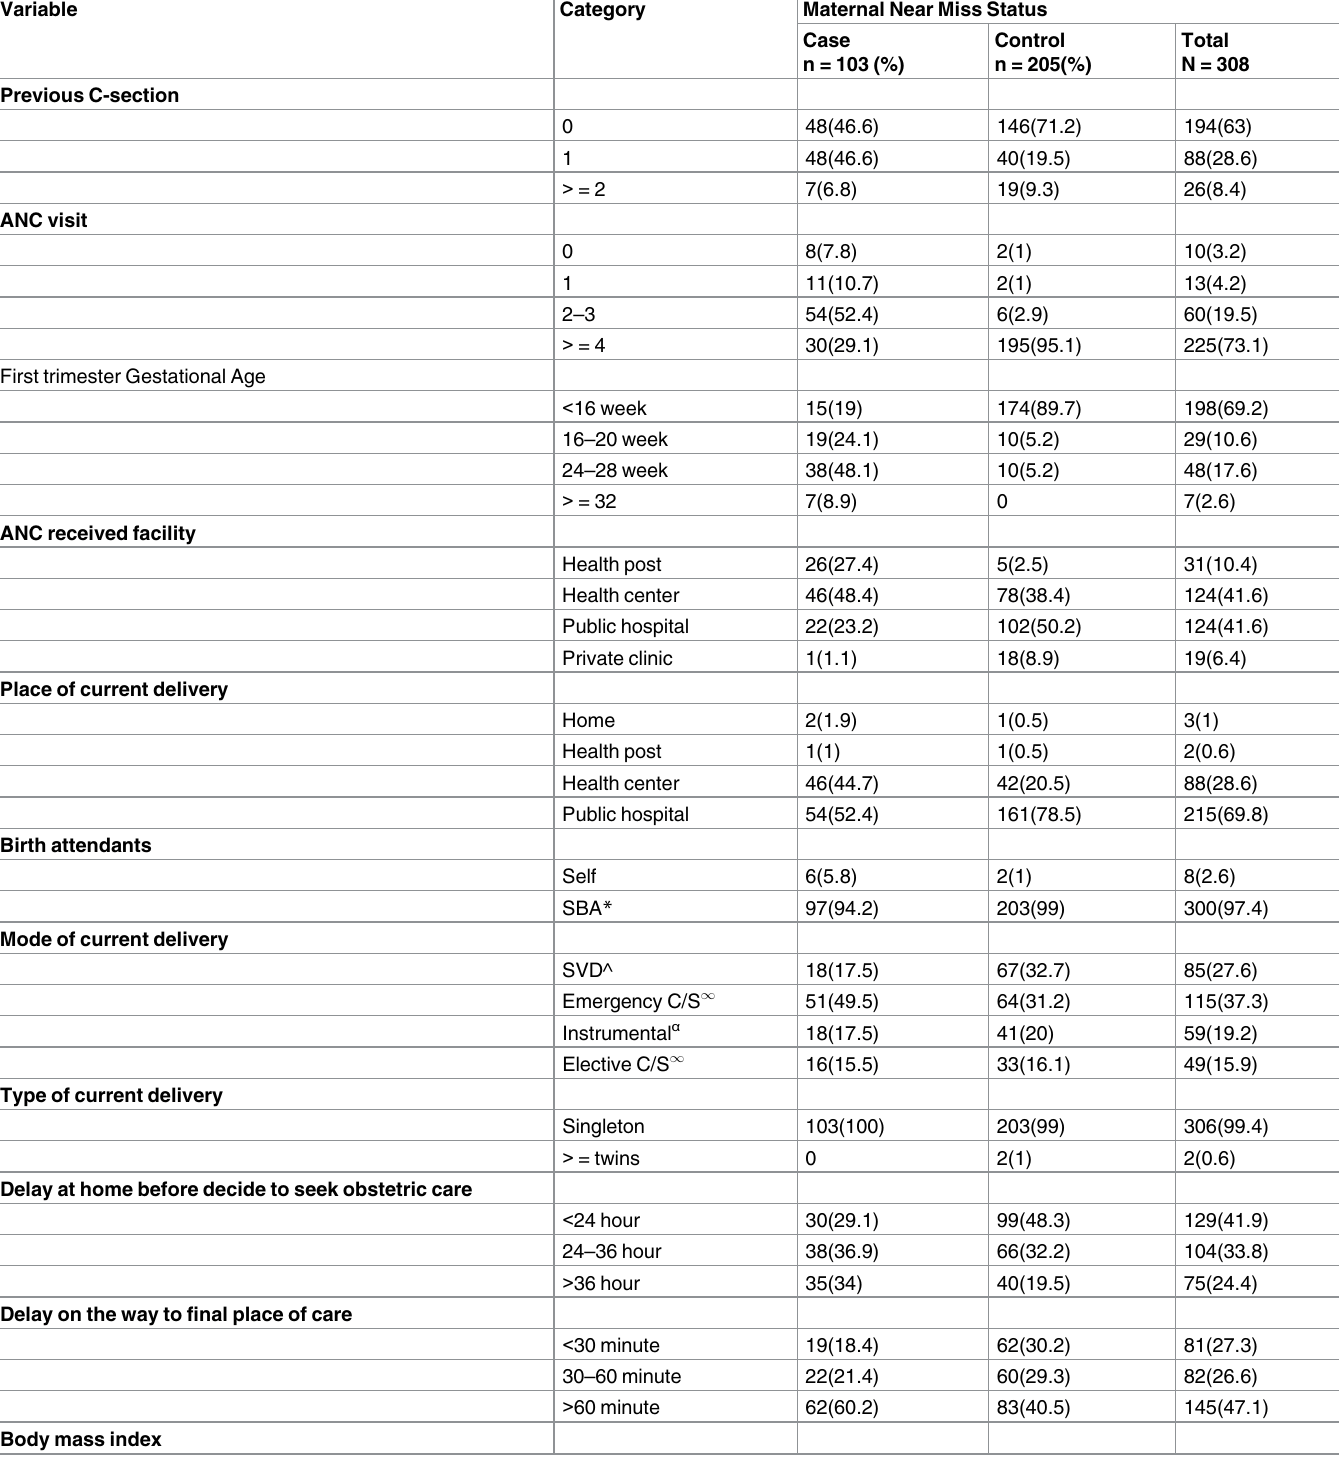
Table 3. Health-related characteristics of mothers admitted in public hospitals, Tigray, Northern Ethiopia, 2016. (N =